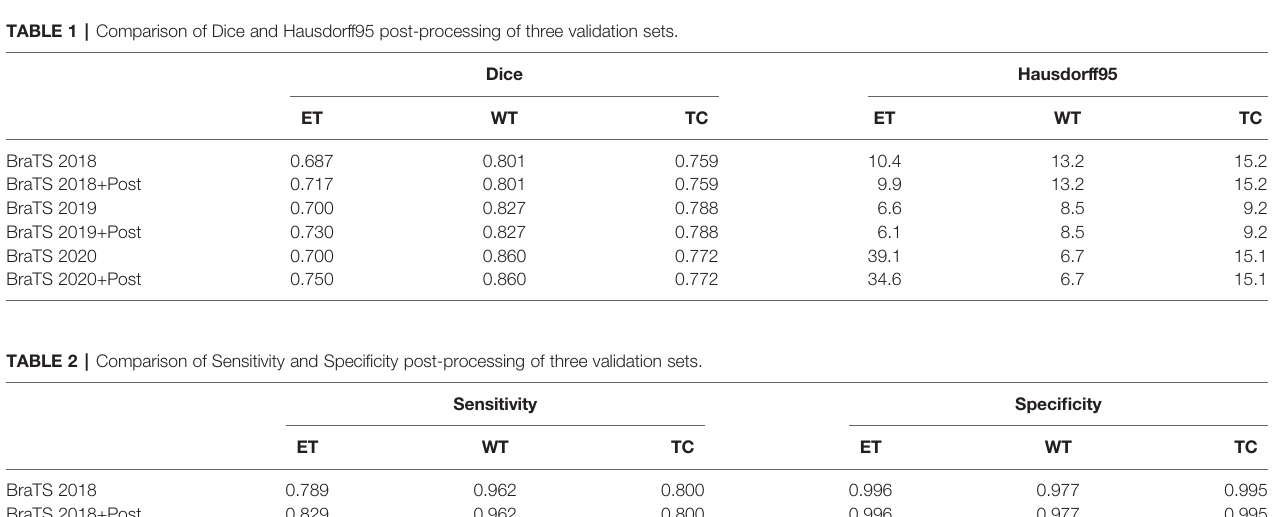
FIGURE 5 | Comparison of the ground truth mask and the prediction during training. Red color represents the tumor core (necrosis), yellow color represents the active tumor and green regions are the edema.